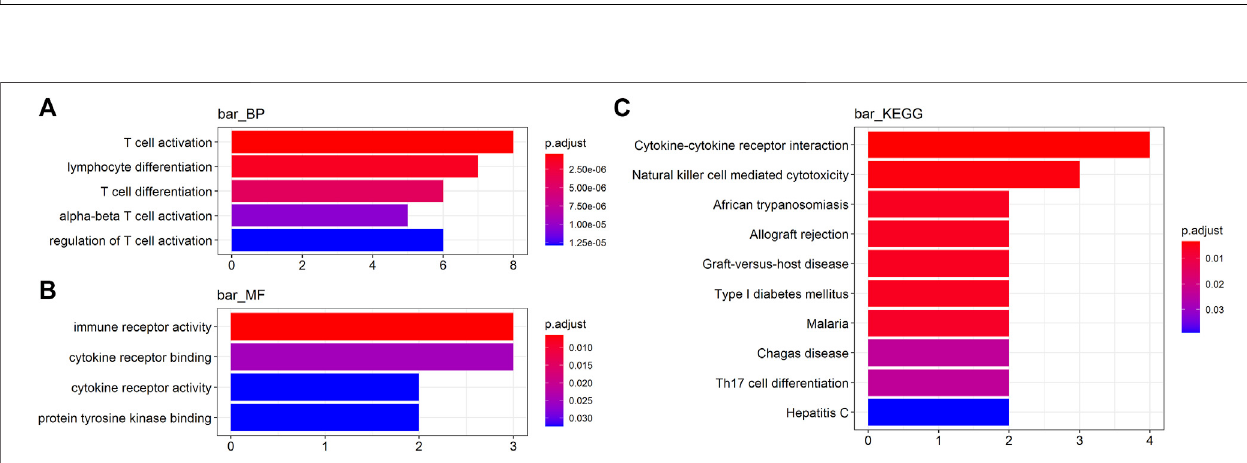
Frontiers in Genetics |